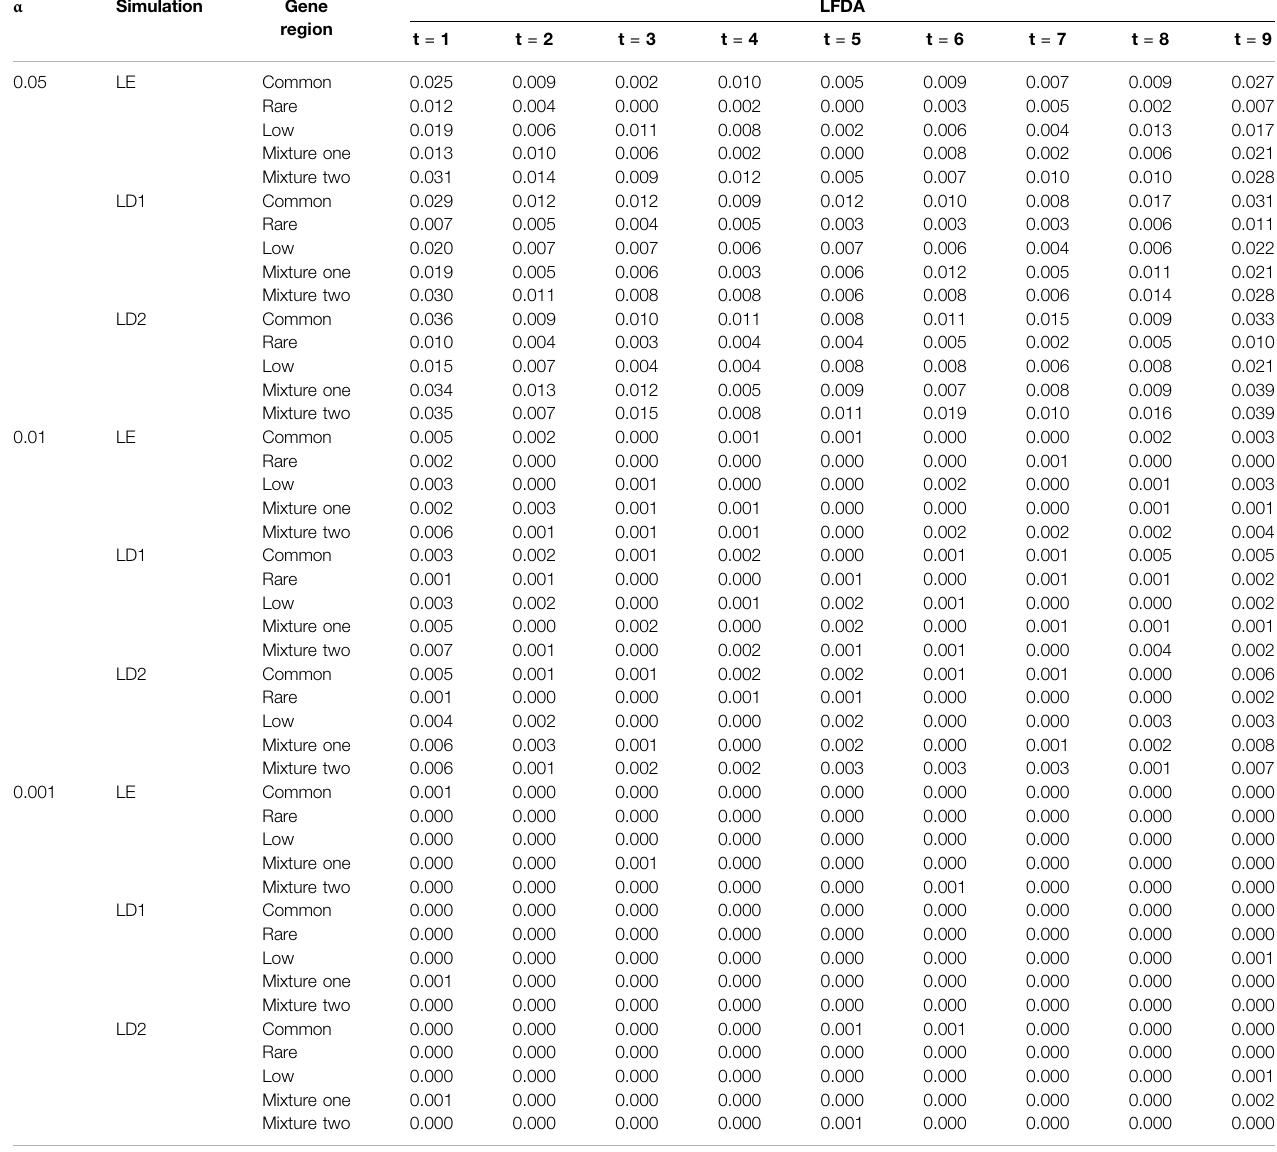
TABLE 7 | Compare the type Ⅰ error rates of linkage equilibrium and linkage disequilibrium simulation based on LFDAT when sample size is 1,500. α Simulation Gene